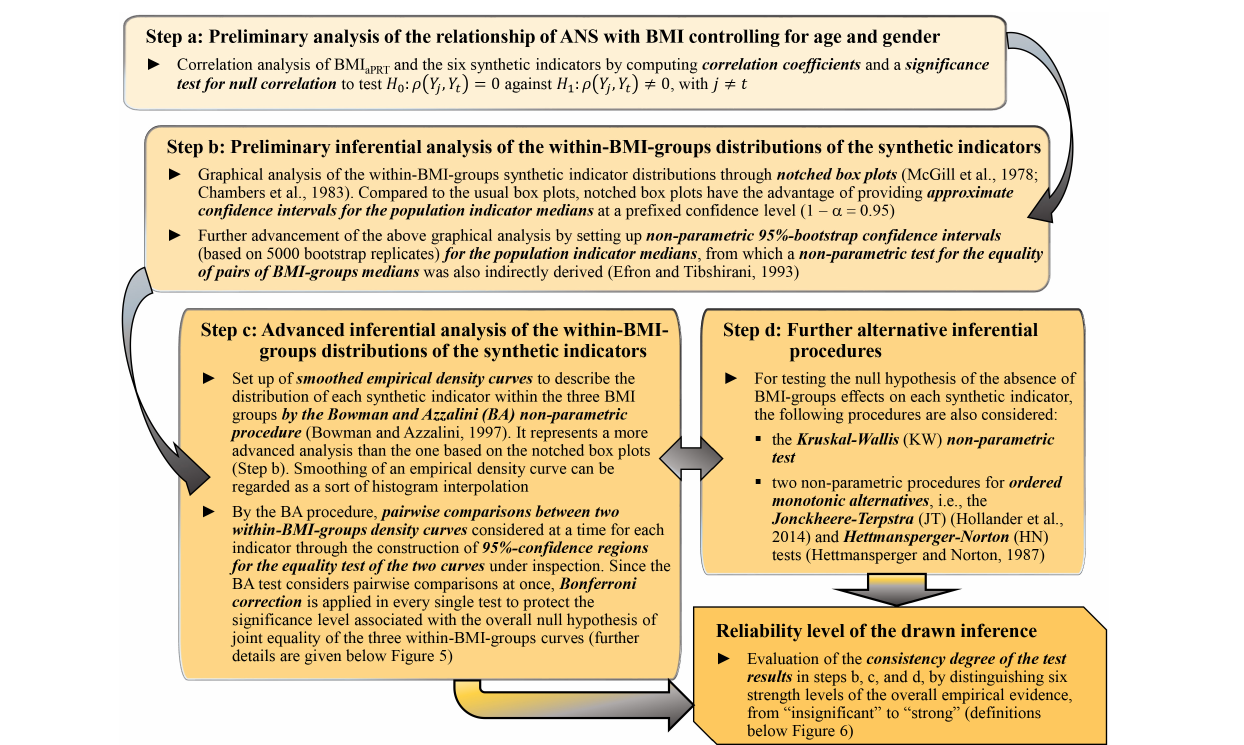
Frontiers in Physiology |